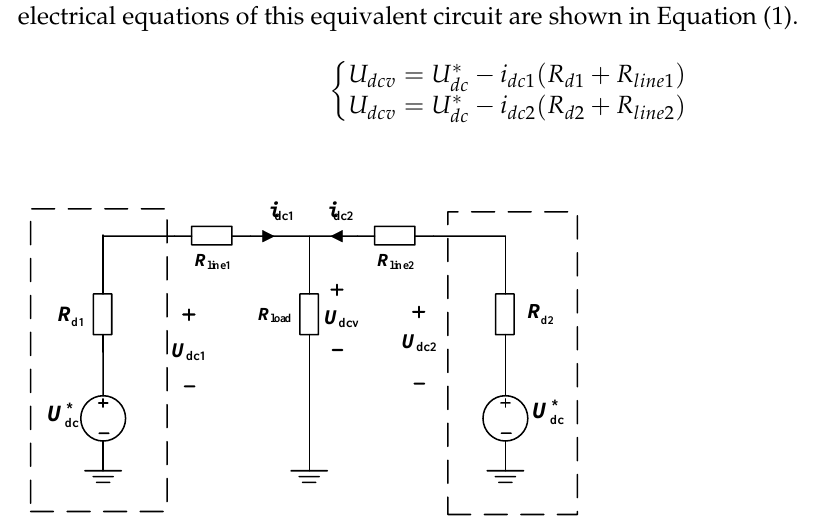
Figure 3. Equivalent circuit diagram of two energy storage modules connected in parallel.